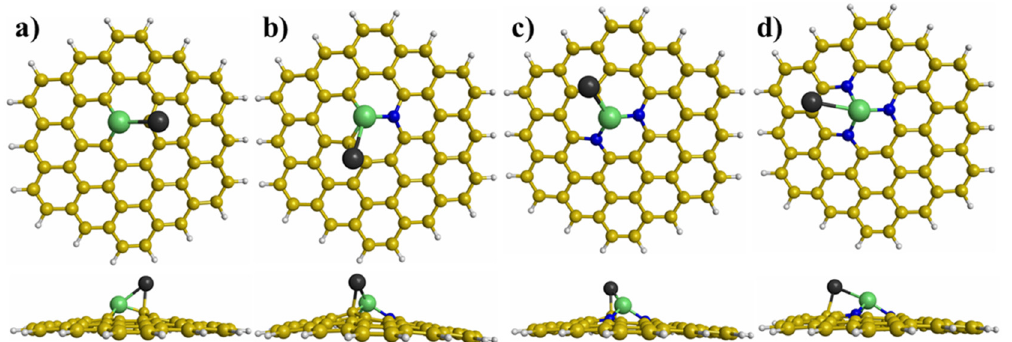
Figure 3. Top and side views of the most stable adsorption sites of the NiPd dimer on graphene with different defects: ( a ) graphene with a vacancy, ( b ) pyridinic N-doped graphene (PNG) with one N atom, ( c ) PNG with two N atoms, and ( d ) PNG with three N atoms.